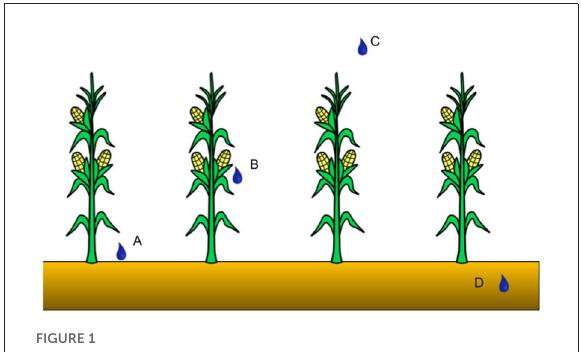
FIGURE1 Irrigation water delivery method conceptualization in the modeling perspective, figure adapted from Valmassoi et al. (2020a). Process A can represent the surface irrigation and the micro, depending on the spatial extent and amount of water used, as well as the sprinkler applied only below the foliage. Process B and C can both represent the sprinkler depending how high above the canopy the sprinkler water is applied. Process D instead reflects the subirrigation. For an in-depth discussion refer to Section